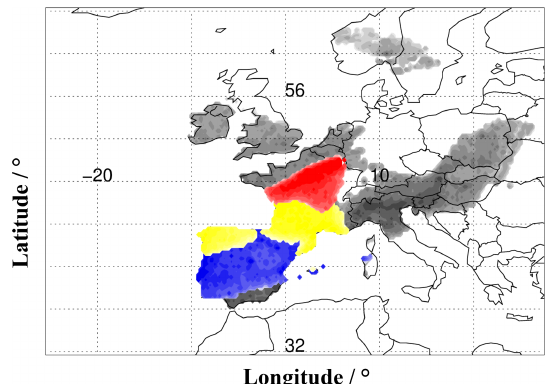
Figure 2. Levoglucosan emission contribution to the EIFE site (green star), divided into age classes, for 1 April 2017. The plot shows source regions for 1d old (35% of the collected levoglu- cosan, red), 2d old (35%, yellow) and 3d old (11%, blue) particles, as well as particles older than that (20%,